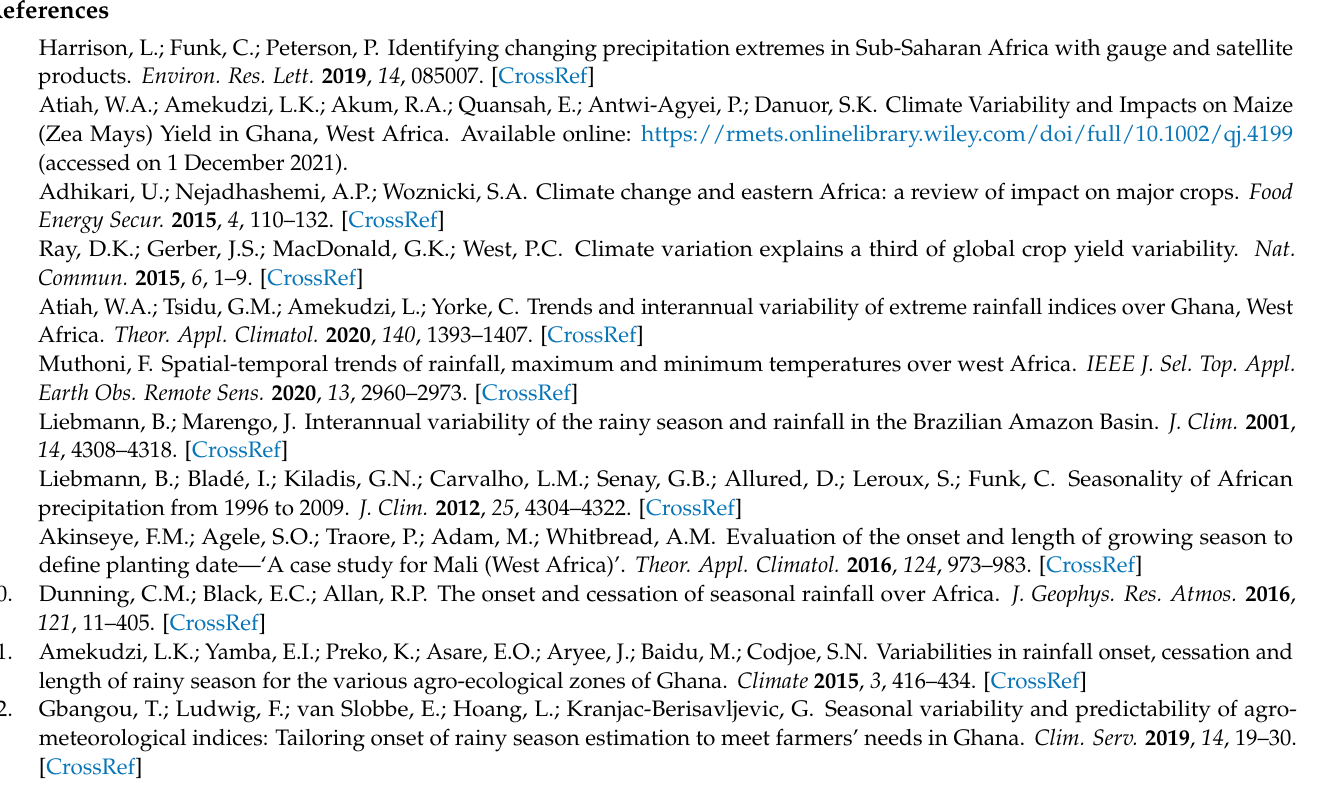
Figure A3. Summary of rainfall onset, cessation and length of growing season over three-gauge stations in northern Ghana. The onset and cessation are days of the year (DOY) while LPG is the number of